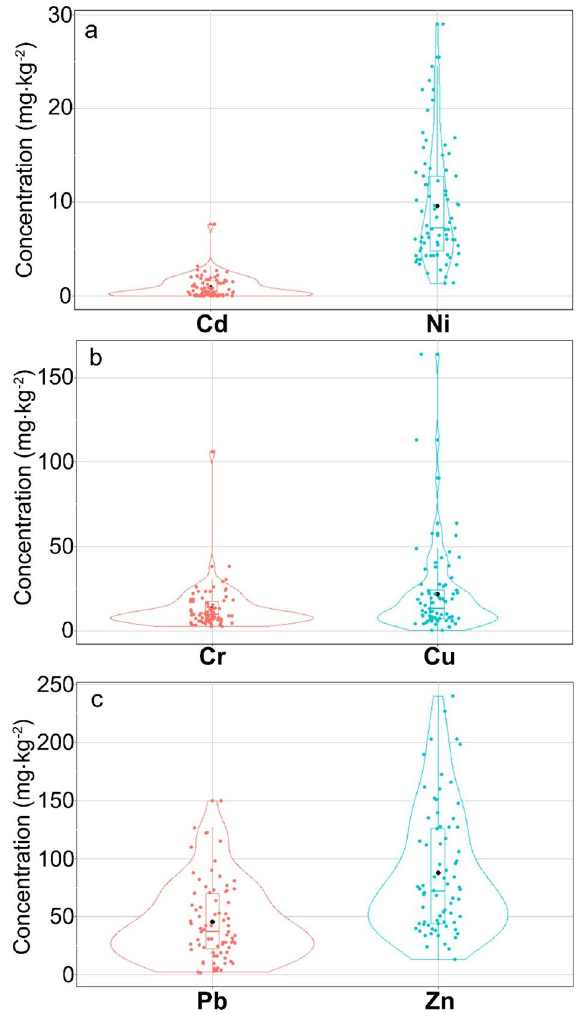
Figure 2. Variability of heavy metal concentrations in surface sediments of lakes in N2 areas: Cd and Ni ( a ), Cr and Cu ( b ), as well as Pb and Zn ( c ).